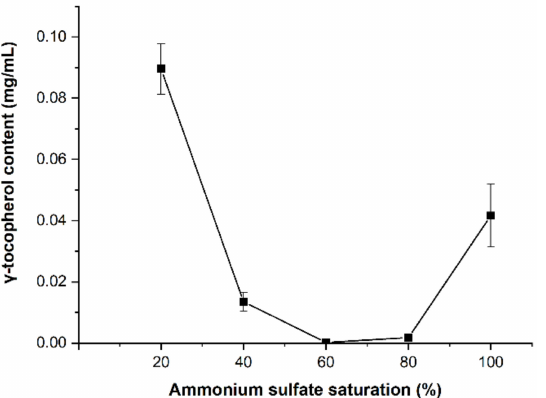
Figure 6. Content of residue γ -tocopherol after reaction with the crude enzyme obtained by ammo- nium sulfate